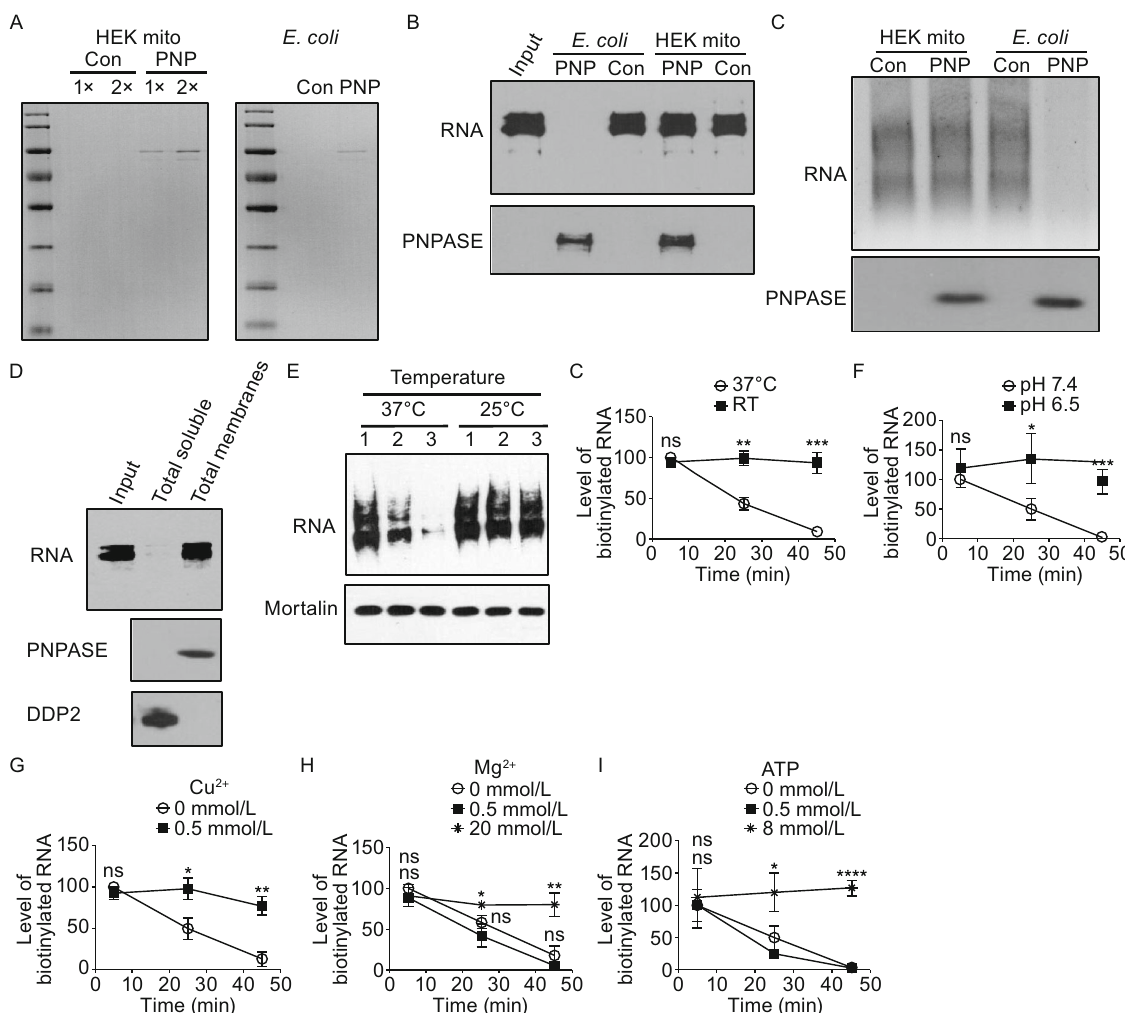
Figure 1. Characterization of mtRNA degradation using an in organello system. (A) Coomassie staining of human PNPASE samples puri fi ed from HEK293 mitochondria (HEK mito) or E . coli . For PNPASE puri fi ed from HEK mitochondria, two concentrations of samples were loaded. Con: same volume of eluate from cells harboring the empty vector; PNP: eluate from PNPASE-HisPC expressing cells. (B) PNPASE puri fi ed from E . coli or HEK mitochondria was incubated with Biotin-labeled UCP2 RNA. The lower panel shows immunoblotting of PNPASE. (C) PNPASE puri fi ed from E . coli or HEK mitochondria was incubated with total cytosolic